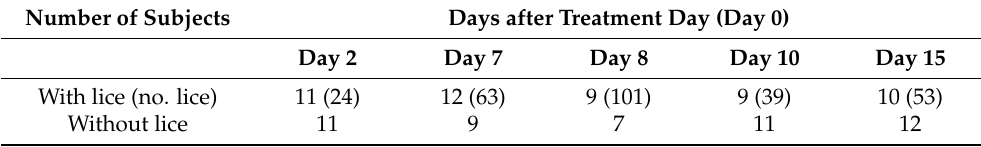
Table 3. Viable lice recovered following treatment with an isopropyl myristate product. Number of Subjects